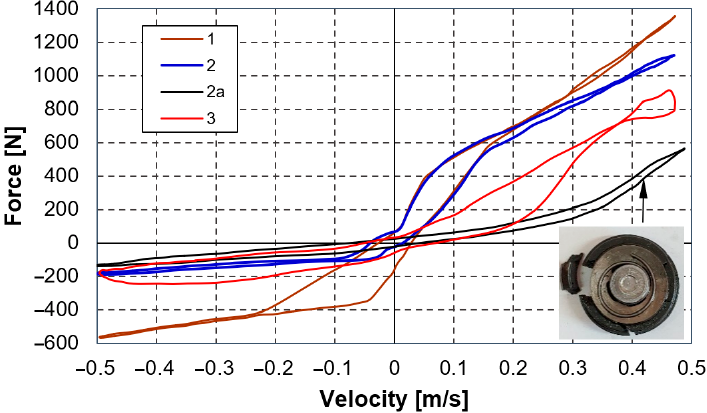
Figure 3. Characteristics of the shock absorber: 1—new, 2—used functional, 2a—used defective, 3— defective.